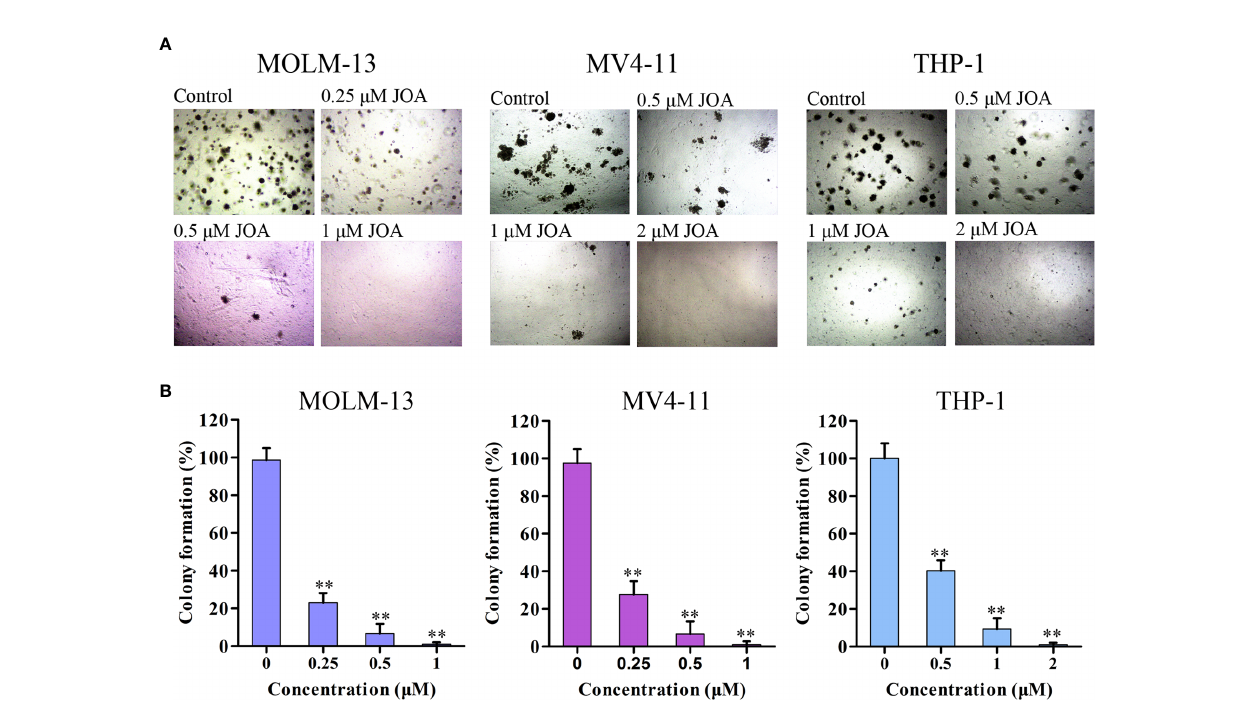
FIGURE 2 | JOA suppresses the colony formation in MV4-11, MOLM-13 and THP-1 cells. (A) Cells were treated with JOA at the concentrations of 0.25- 2 m M for 12 days then the cell morphology was observed under light microscopy. (B) Graph bars show the number of colonies (**p < 0.01). The colony formation assay was performed for three